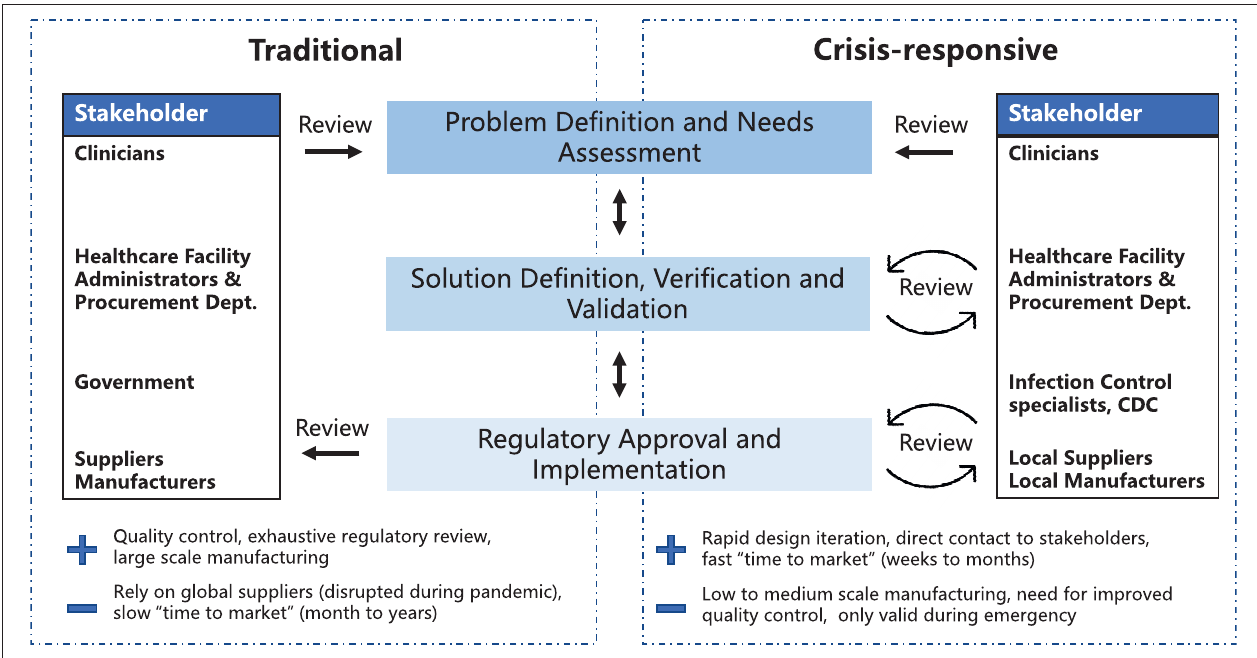
FIGURE 1 | Traditional and crisis-responsive design framework for medical device development. The crisis-responsive framework places emphasis on repeated design review using input from a broad range of stakeholders, all of whom may face unique constraints due to the